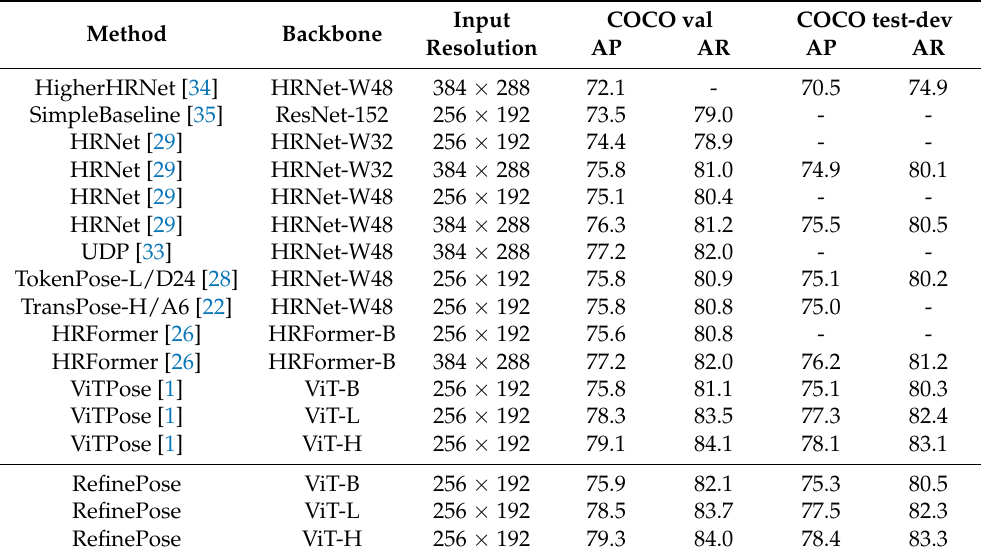
Table 1. Comparison with SOTA methods on the MS COCO val and test-dev